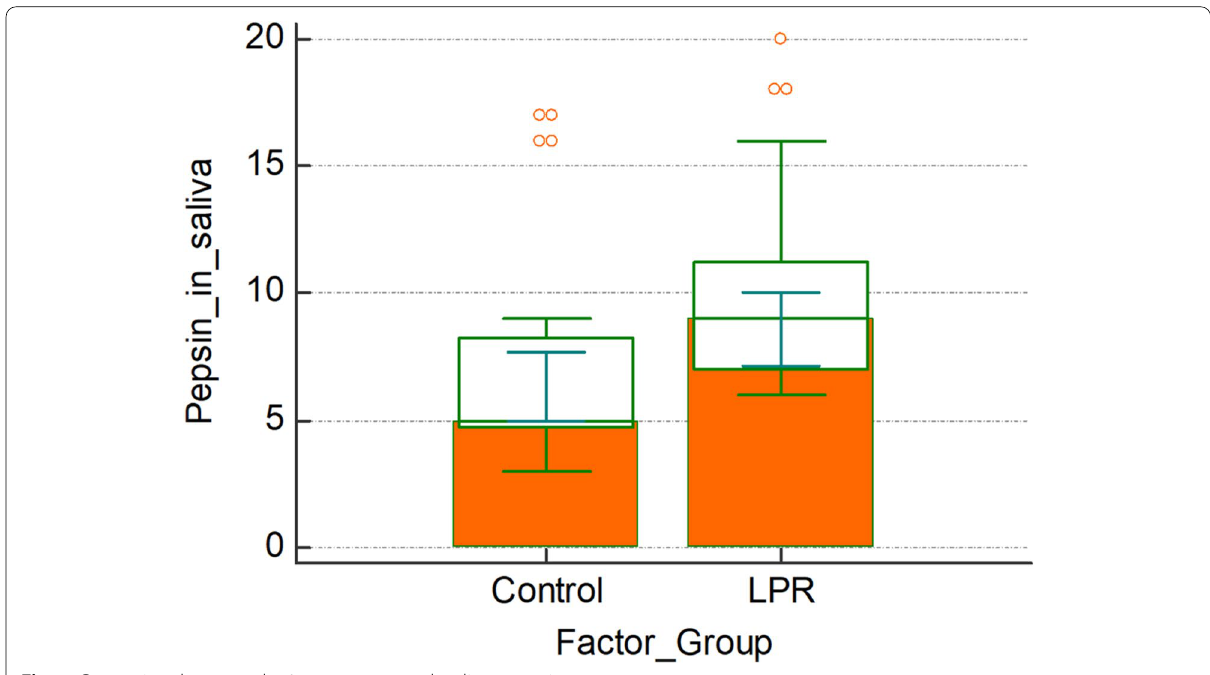
Fig. 1 Comparison between the 2 groups as regards salivary pepsin